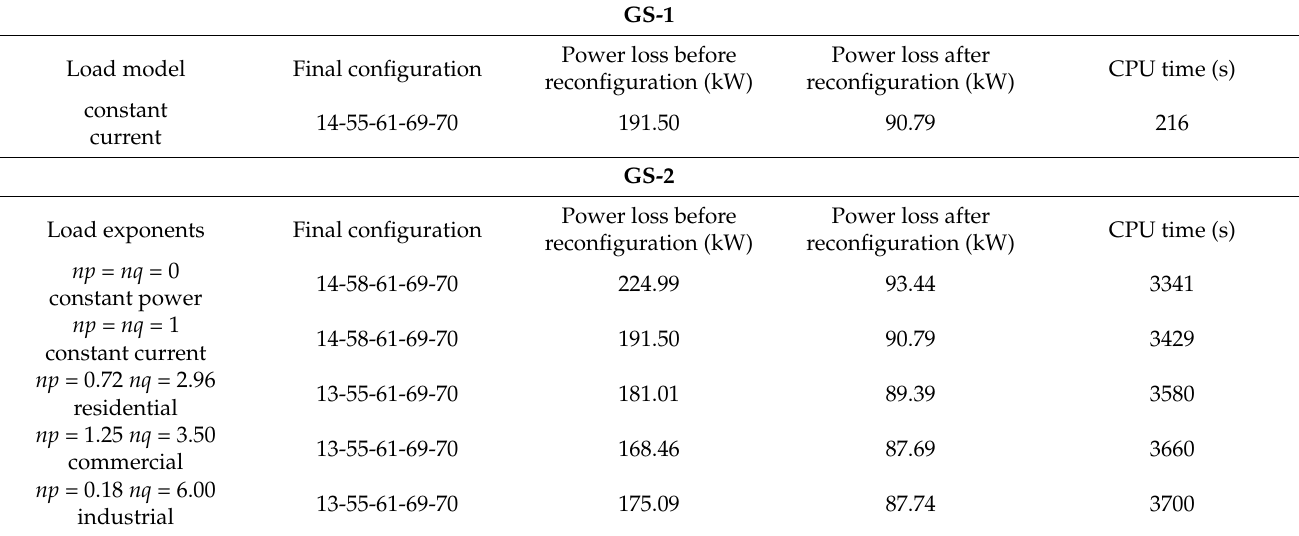
Table 3. The 69-bus system reconfiguration